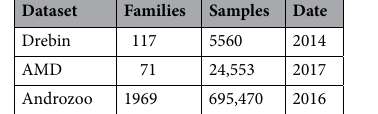
Table 3. Summary of selected Malware